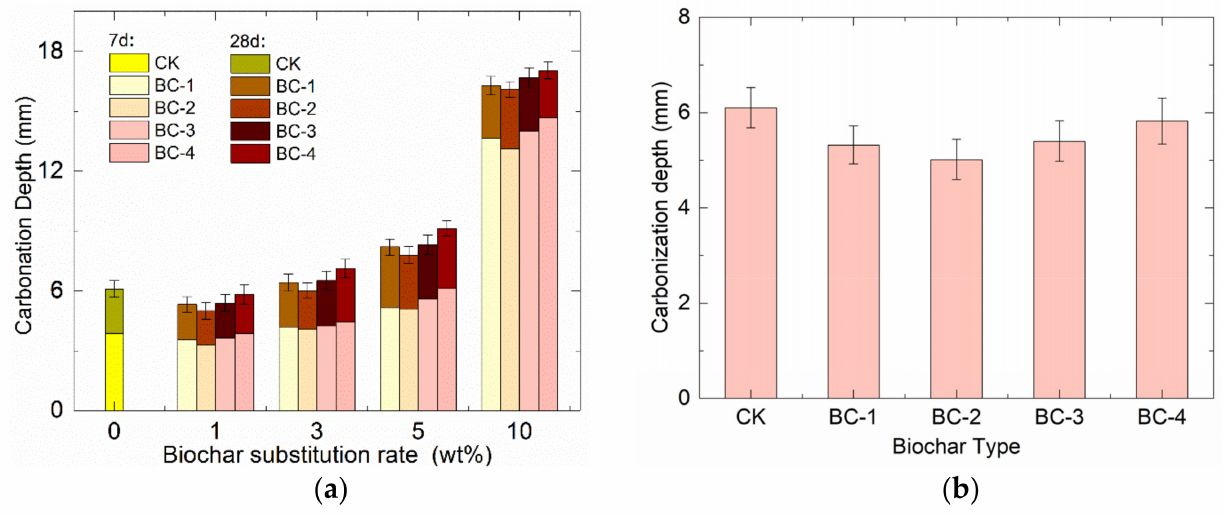
Figure 4. Relationship between: ( a ) biochar dosage and carbonization depth; and ( b ) different types of biochar and chloride diffusion coefficients at 1%